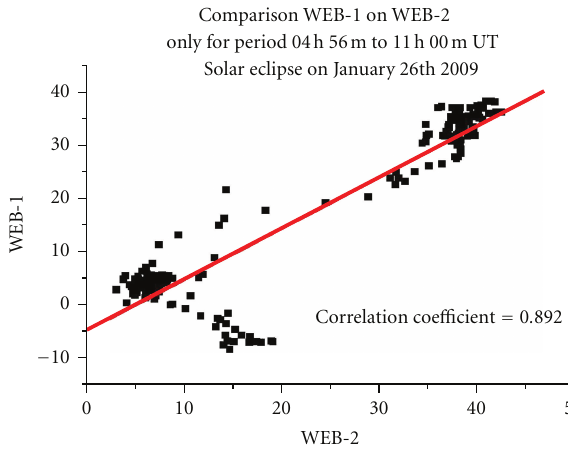
Figure 6: Correlation of readings of WEB-1 versus WEB-2 during the time interval T 1– T 6.